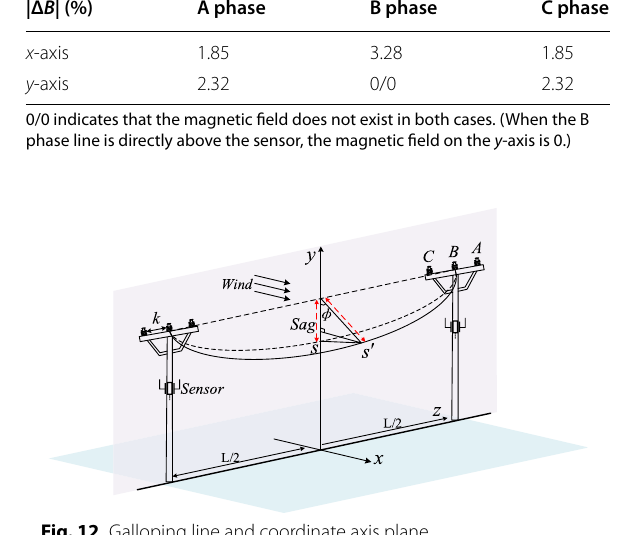
Fig. 12 Galloping line and coordinate axis